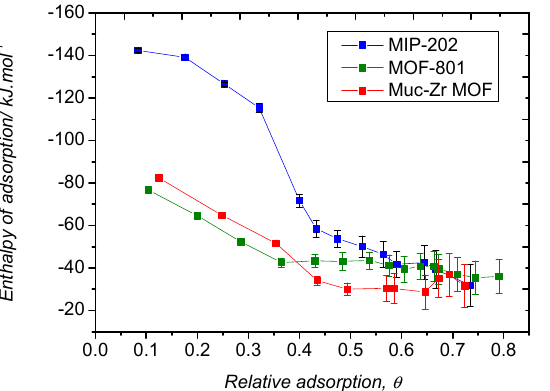
Figure 10. Enthalpic profiles obtained by microcalorimetry upon adsorption of ethanol by the three MOFs at 303 K.